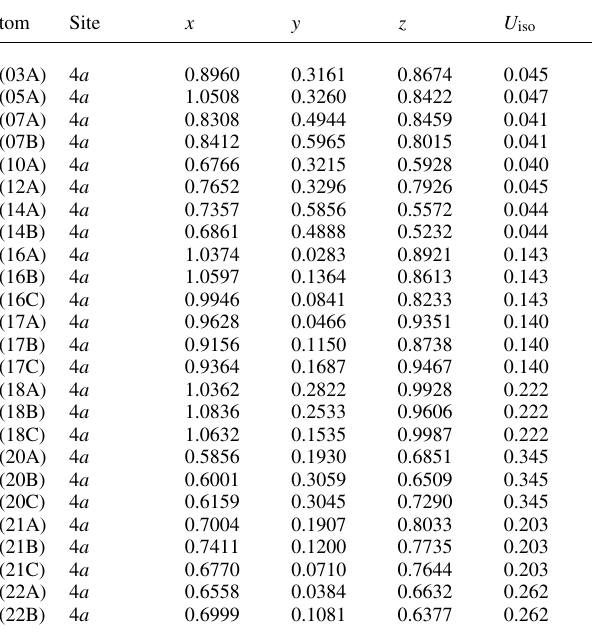
Table 2. Atomic coordinates and displacement parameters (in Å 2 ) .